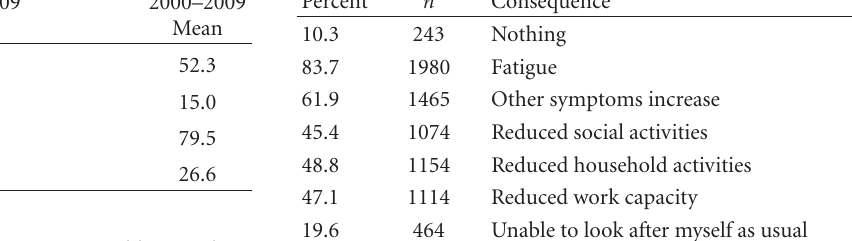
Table 2: Australian mean annual maximum apparent temperature.